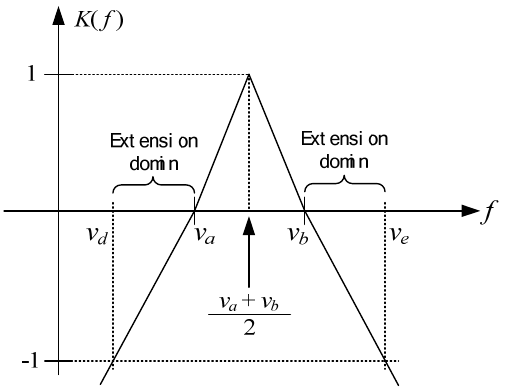
Figure 8. Schematic of the elementary correlation function.